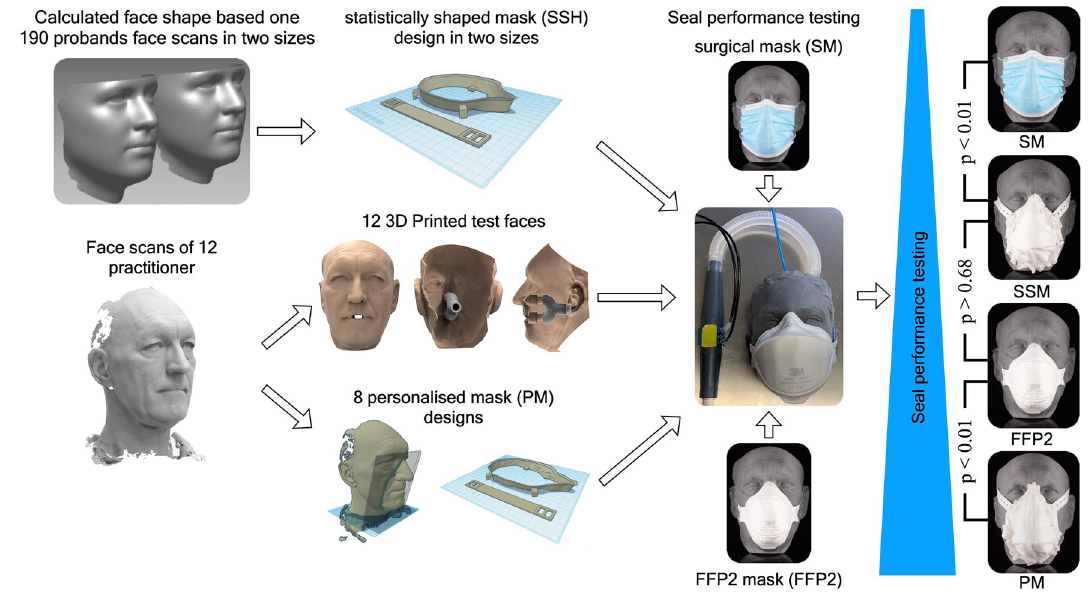
Figure 1. Graphical Abstract summarizing the workflow of mask and test face design, seal performance testing and the archived